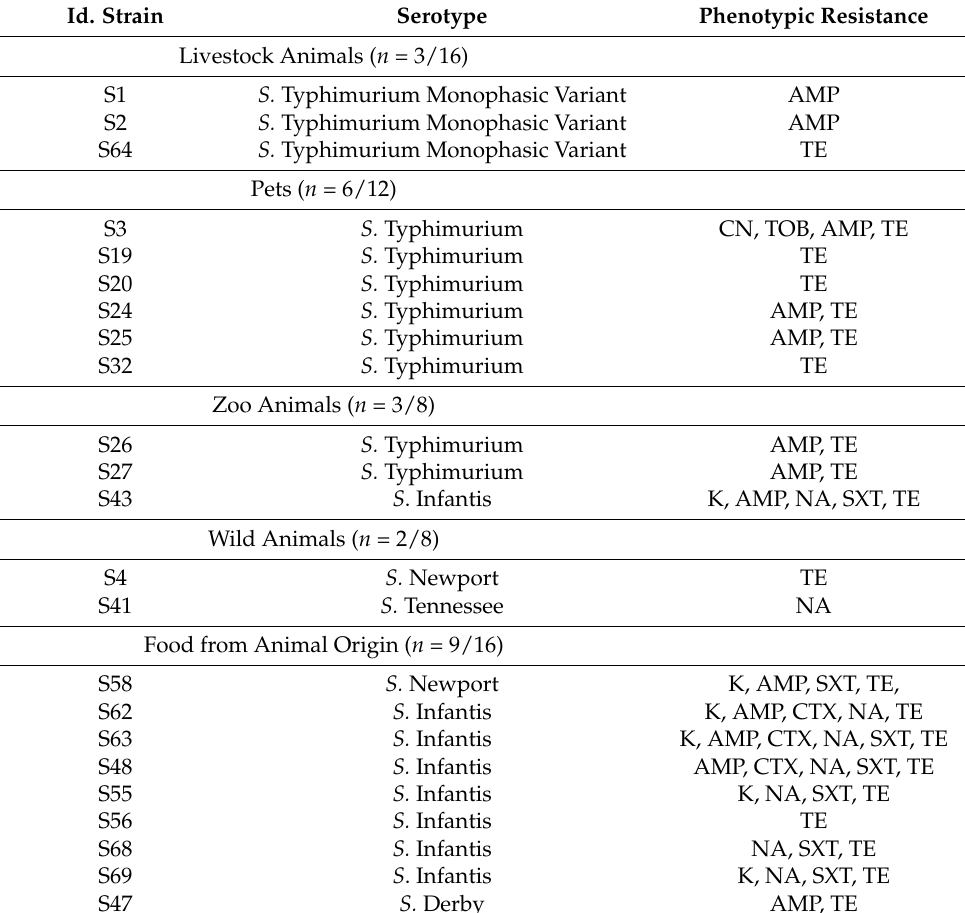
Table 2. Phenotypic resistance